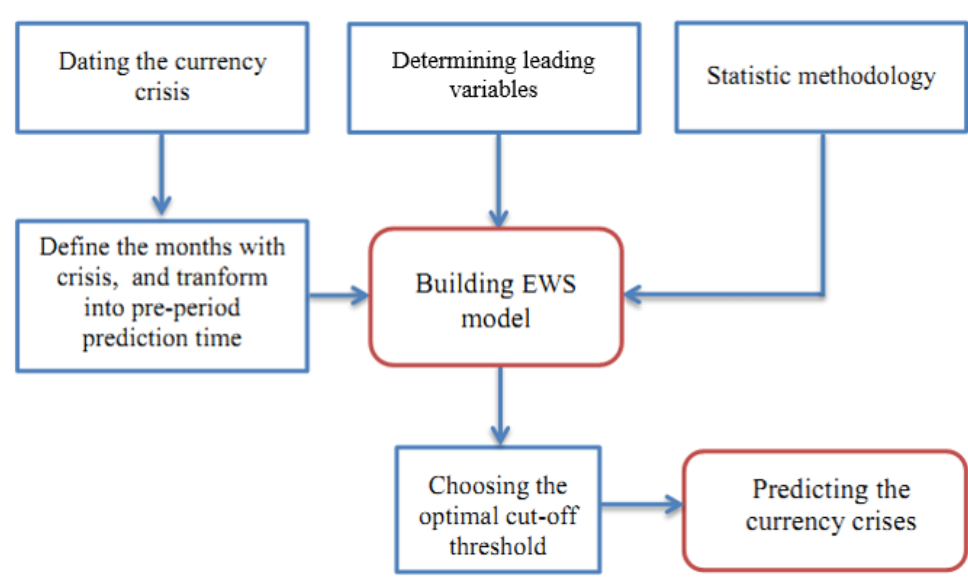
Figure 1. The EWS model to predict currency crises.